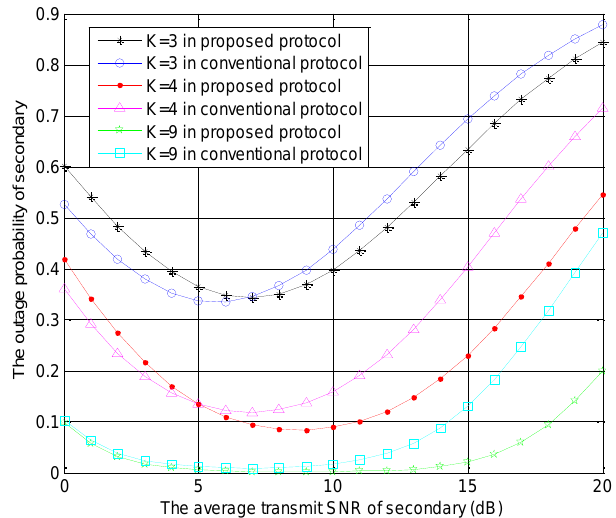
Figure 3. The outage probability of secondary system versus r 2 in the two protocols with different K values.